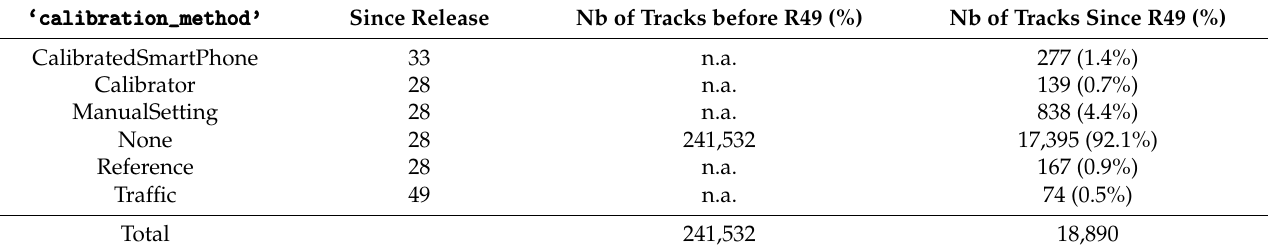
Table 15. Distribution of tracks in function of the calibration method, before and after release 49 (’n.a.’ for ‘not available’).